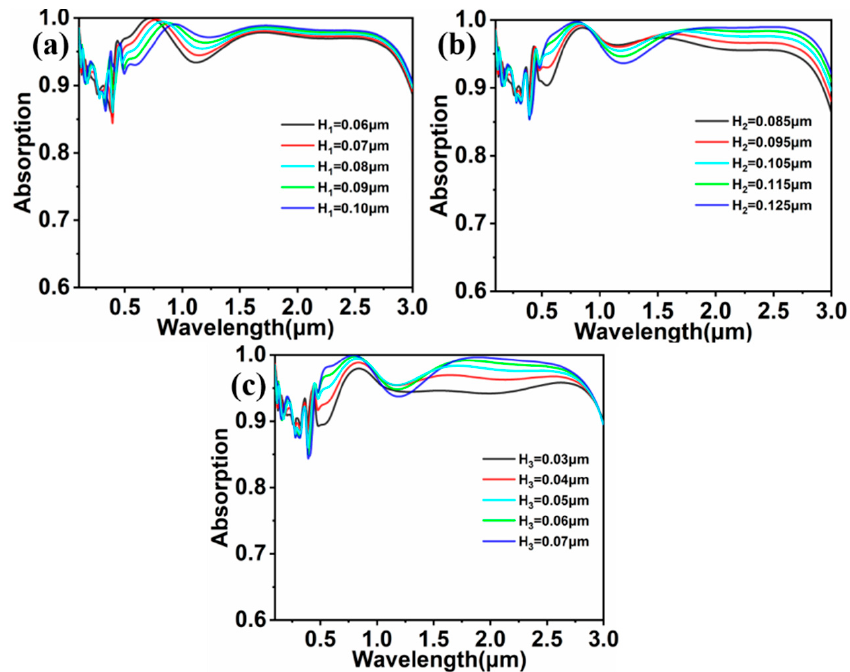
Figure 5. Simulated absorption spectrograms of the thickness parameter variation of the designed absorber surface structure. ( a ) Absorption spectra at different H 1 ; ( b ) Absorption spectra at different H 2 ; ( c ) Absorption spectra at different H 3